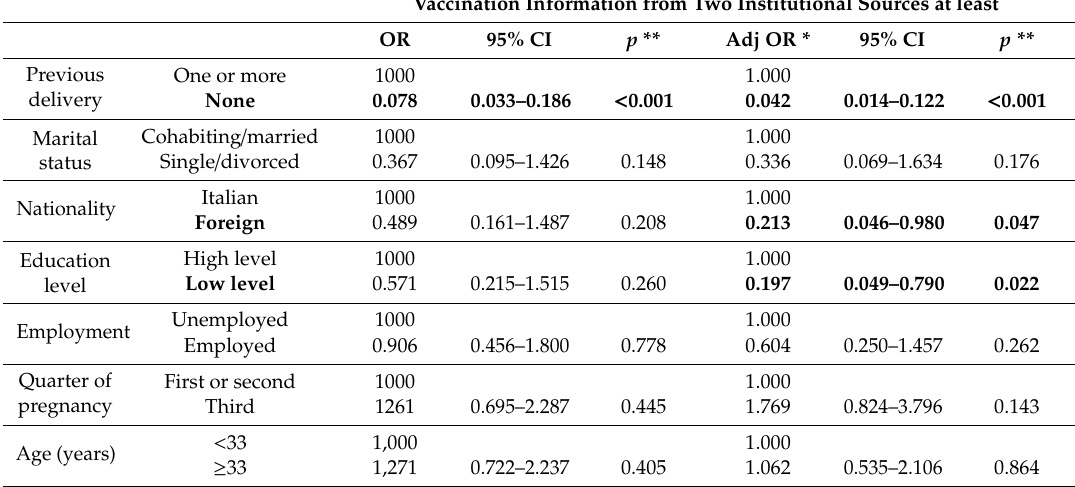
Table 2. Association between socio-demographic data and vaccine information from institutional sources. OR, odds ratio; CI, confidence interval.